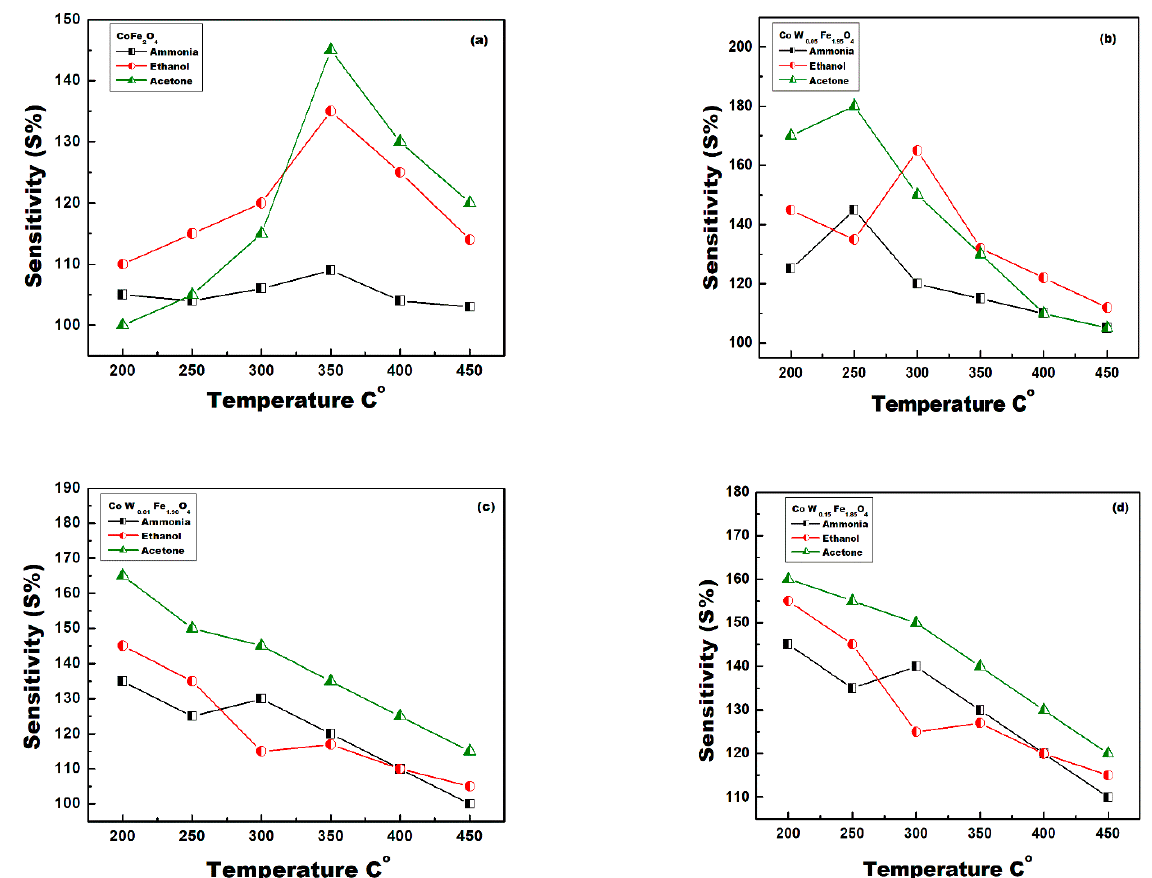
Figure 12. Sensors sensitivity at different temperatures exposed to 2000 ppm acetone, ethanol, and ammonia; ( a ) CoFe 2 O 4 , ( b ) CoFe 2 O 4 -0.5%W, ( c ) CoFe 2 O 4 -1.0%W, ( d ) CoFe 2 O 4 -1.5%W.